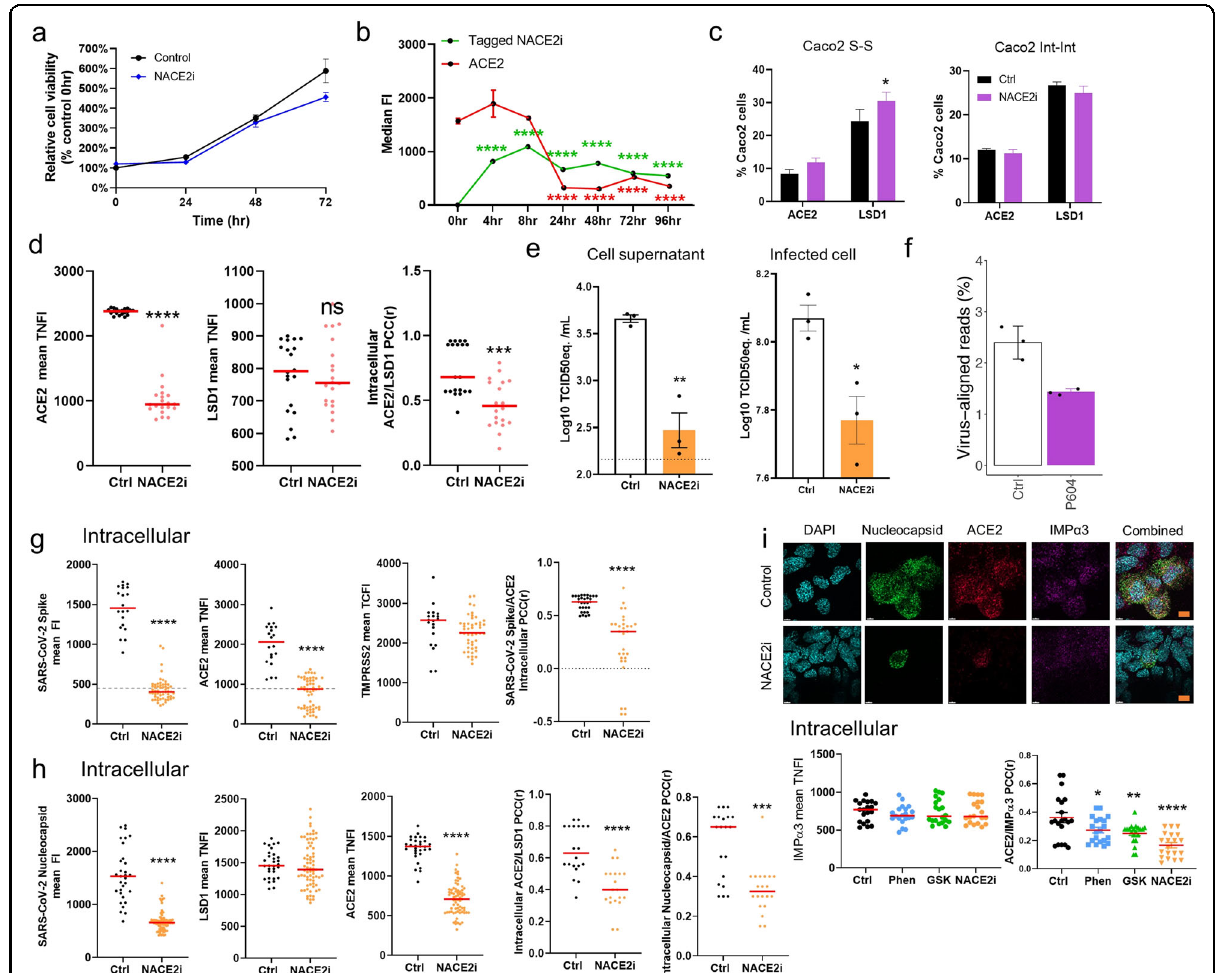
Fig. 5 A novel ACE2 peptide inhibitor. a Cell proliferation analysis of Caco-2 control (depicted in Fig. 3) and NACE2i (50 μ M)-treated cells over a 72 h period. Proliferation was analyzed using WST-1 reagent and absorbance read after 2 h incubation. The graph depicts relative cell proliferation from triplicates expressed as a percentage of control cells (untreated, 0 h). Statistical signi fi cance was calculated using one-way ANOVA at each time point. b The ASI Digital pathology system was used to analyze ACE2 expression over time in Caco-2 cells treated with NACE2i (with FAM5 TAG). Dot plots displays the nuclear fl uorescence intensity in Caco-2 cells for ACE2 and FAM5 tag as well as the % population of ACE2-expressing cells, >20 cells counted per group. Data represent mean ± SEM. Mann – Whitney test. ∗∗∗∗ P < 0.0001 denote signi fi cant differences. c FACS analysis of cell surface and intracellular expression of ACE2 and LSD1 in Caco-2 cells treated with/without NACE2i for 48 h. The bar graph indicates the percentage ACE2 + or LSD1 + cells of the total Caco-2 population. Data are mean ± SEM ( n = 3). Mann – Whitney test. ∗ P < 0.05 denote signi fi cant differences. d Dot plot quanti fi cation of the fl uorescence intensity (intracellular) of ACE2 and LSD1 in Caco-2 cells with NACE2i treatment. >50 cells were analyzed for each group. The PCC was calculated for colocalization ( n = 20 cells were analyzed). Mann – Whitney-test: ∗∗∗ P < 0.001, ∗∗∗∗ P < 0.0001 denote signi fi cant differences. e qRT-PCR analysis to detect replicates of SARS-CoV-2 RNA in Caco-2 culture supernatants and infected cells at the indicated time points post-infection. The quantity of viral genome is expressed as TCID 50 equivalents/mL. Data represent mean ± SEM, n = 3. One-way ANOVA, ∗ P < 0.05, ∗∗ P < 0.01 denote signi fi cant differences. f SARS-CoV-2 levels in infected Caco-2 cells. The percentage of virus-aligned reads (over total reads) is indicated for each sample. Error bars represent standard deviation from three independent biological replicates. g Dot plot quanti fi cation of the fl uorescence intensity (intracellular) of SARS-CoV-2 spike, ACE2, LSD1, and TMPRSS2 in SARS-CoV-2-infected Caco-2 cells with phenelzine, GSK, or NACE2i treatment. >50 cells were analyzed for each group. The PCC was calculated to assess colocalization ( n = 20 cells were analyzed). Data are mean ± SEM. Mann – Whitney-test: ∗∗∗∗ P < 0.0001 denote signi fi cant differences. h Dot plot quanti fi cation of the fl uorescence intensity (intracellular) of SARS-CoV-2 nucleocapsid, ACE2, and LSD1 in SARS-CoV-2-infected Caco-2 cells with phenelzine, GSK, or NACE2i treatment. >50 cells were analyzed for each group. The PCC was calculated to assess colocalization ( n = 20 cells were analyzed). Data are mean ± SEM. Mann – Whitney-test: ∗∗∗ P < 0.001, ∗∗∗∗ P < 0.0001 denote signi fi cant differences. i Representative image of uninfected or SARS-CoV-2 infected Caco-2 cells using the Andor WD Revolution Inverted Spinning Disk microscopy system. SARS-CoV-2-infected Caco-2 cells with phenelzine, GSK, or NACE2i treatment, followed by permeabilization (intracellular) for immunostaining for SARS-CoV-2 nucleocapsid, ACE2, and IMP α 3. DAPI (blue) was used to visualize nuclei. Scale bar, 12 mm (inset). Dot plot quanti fi cation of the fl uorescence intensity of IMP α 3 in SARS-CoV-2-infected Caco-2 cells. >50 cells were analyzed for each group. The PCC was calculated to assess colocalization ( n = 20 cells were analyzed). Data are mean ± SEM. Mann – Whitney test: ∗ P < 0.05, ∗∗ P < 0.01, ∗∗∗∗ P < 0.0001 denote signi fi cant